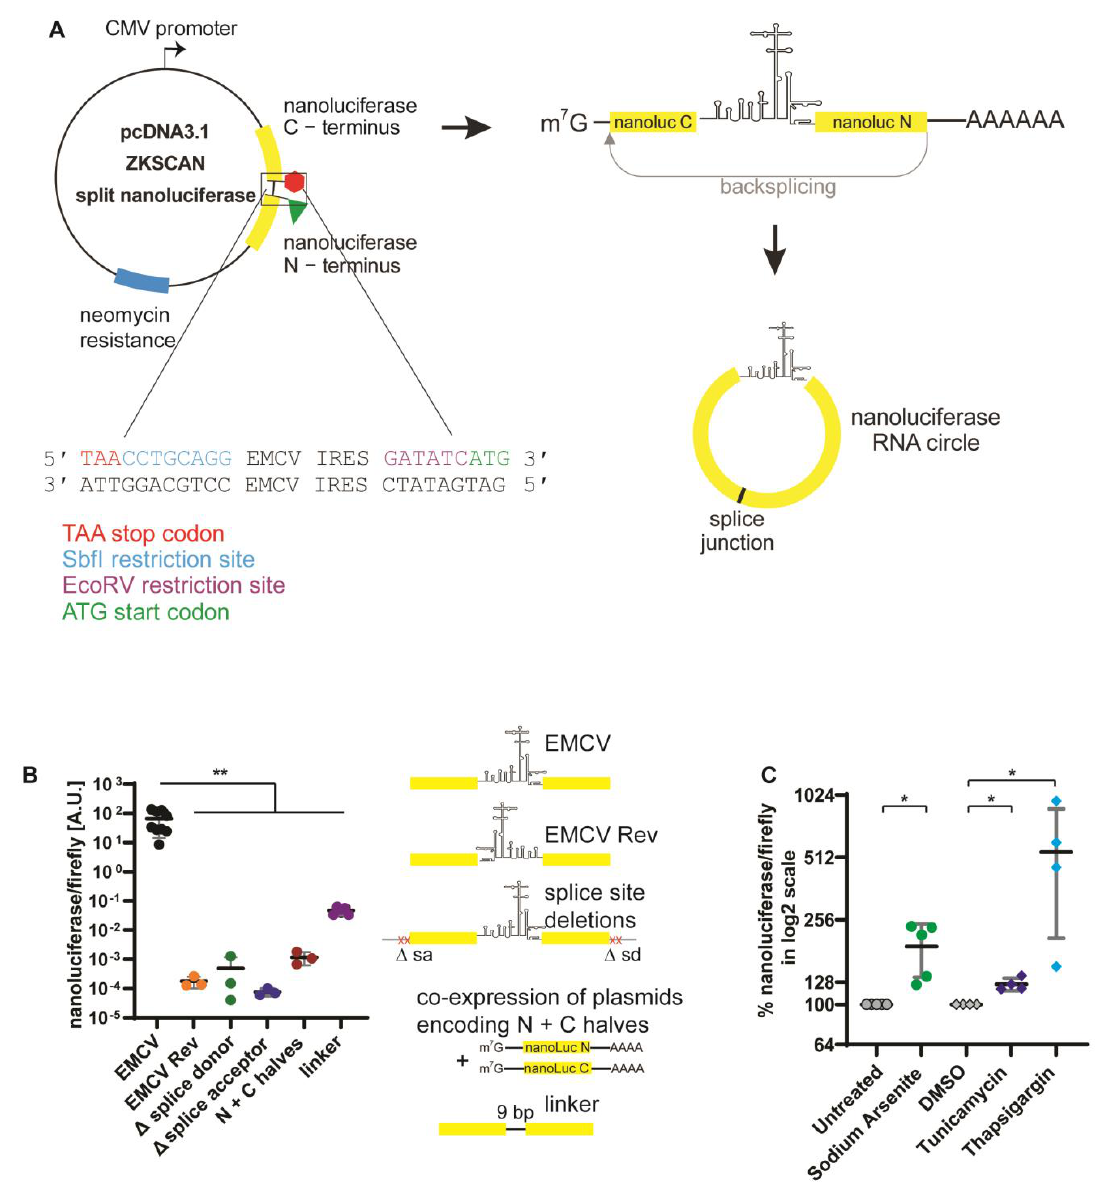
Figure 1. A split NanoLuc reporter quantitatively measures translation from a circular RNA. ( A ) ZKSCAN split NanoLuc plasmid construct contains SbfI and EcoRV restriction sites, into which the EMCV IRES had been inserted. Upon transcription, a linear capped and polyadenylated transcript is formed. Upon backsplicing, the split NanoLuc open reading frame (ORF) is fused, which results in active NanoLuc protein. ( B ) NanoLuc over firefly luciferase luminescence ratios is plotted for the different control constructs containing the EMCV IRES in the forward (EMCV) or reverse orientation (EMCV Rev), the EMCV IRES in the forward direction with the intronic splice donor ( ∆ splice donor) or acceptor sites ( ∆ splice acceptor) deleted, co-expression of N − and C − terminal fragments (N + C halves) from two co-transfected DNA plasmids, and the empty plasmid with a short 9 bp unstructured linker inserted into the SbfI and EcoRV sites (linker). Schematics corresponding to the constructs tested here are shown to the right. ( C ) NanoLuc expression from circular RNAs in response to cellular stress induced by sodium arsenite, tunicamycin and thapsigargin compared to an untreated and a DMSO control. NanoLuc expression normalized to firefly luciferase is displayed in a percentage. All experiments were performed at least in triplicate. Error bars represent the stan- dard deviation. Significances were calculated using an unpaired t test with Welch’s correction with p ≤ 0.05 = *, p ≤ 0.01 =